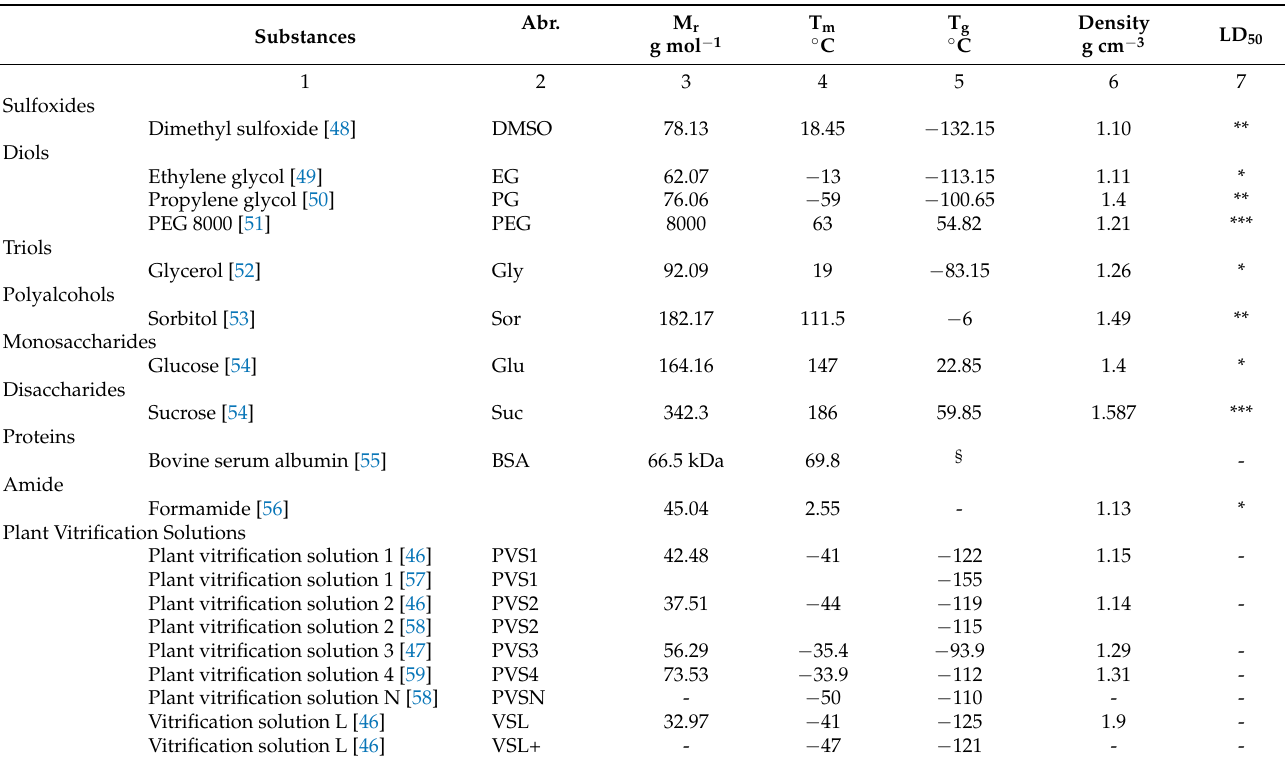
Table 1. Characteristics of commonly used vitrification solutions and their chemical and physical properties in PVS.